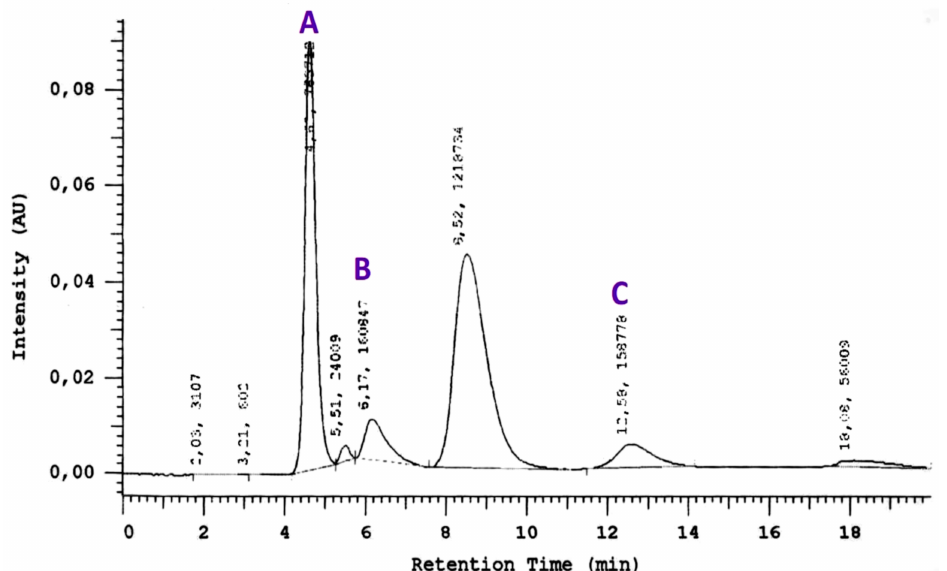
Figure 1. A representative chromatogram with the concentration–AUC plots for cysteine ( A ), homo- cysteine ( B ) and glutathione ( C